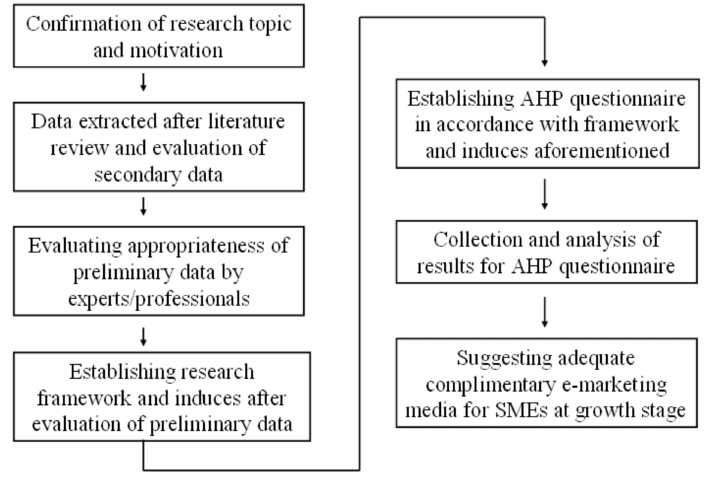
Figure 1. Research structure of this study.